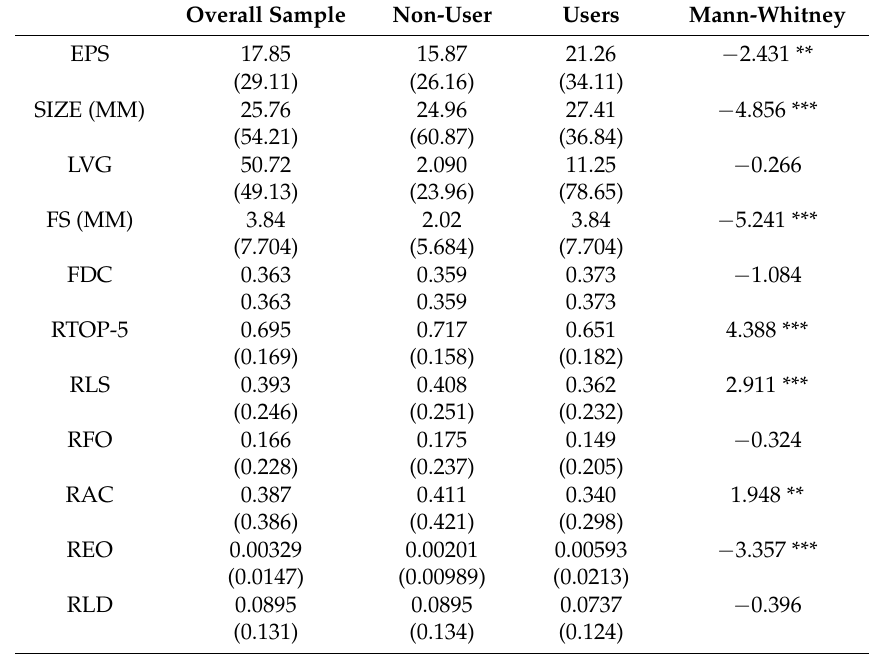
Table 2. Descriptive Statistics and Man-Whitney U